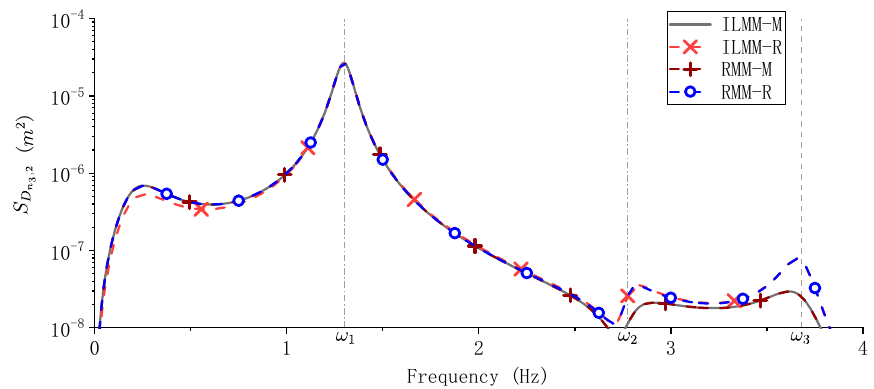
Figure 11. Comparison of the power spectral density (PSD) of D n Figure 11 . Comparison of the power spectral density (PSD) of (cid:1830) (cid:3041) and RMM-M are